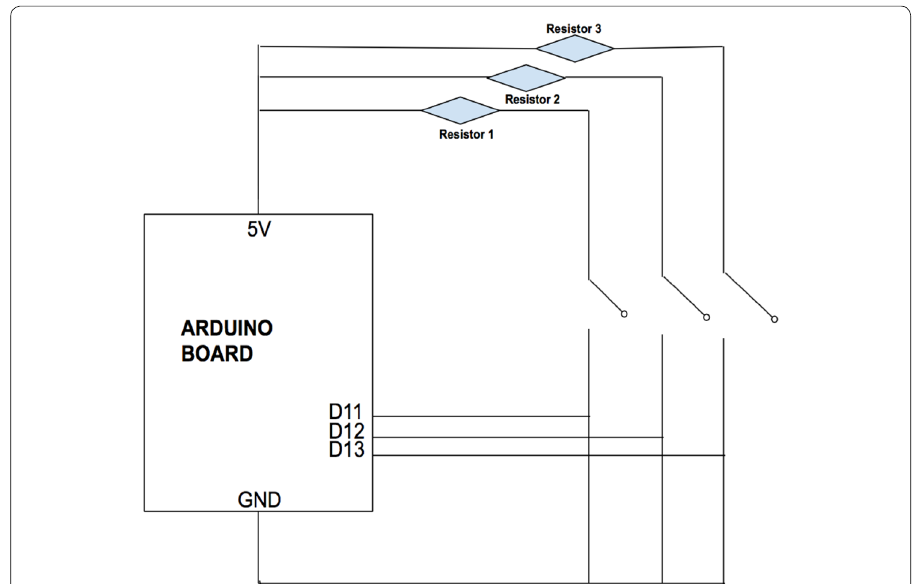
Fig. 3 Parallel circuit setup of pressure sensor